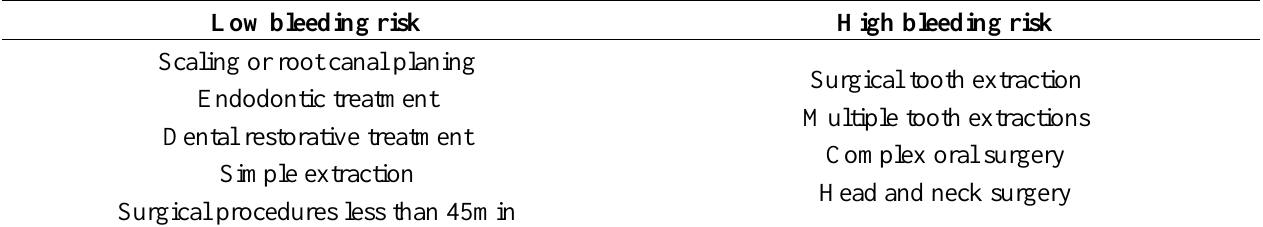
Table 2. Dental procedures classified according to their bleeding